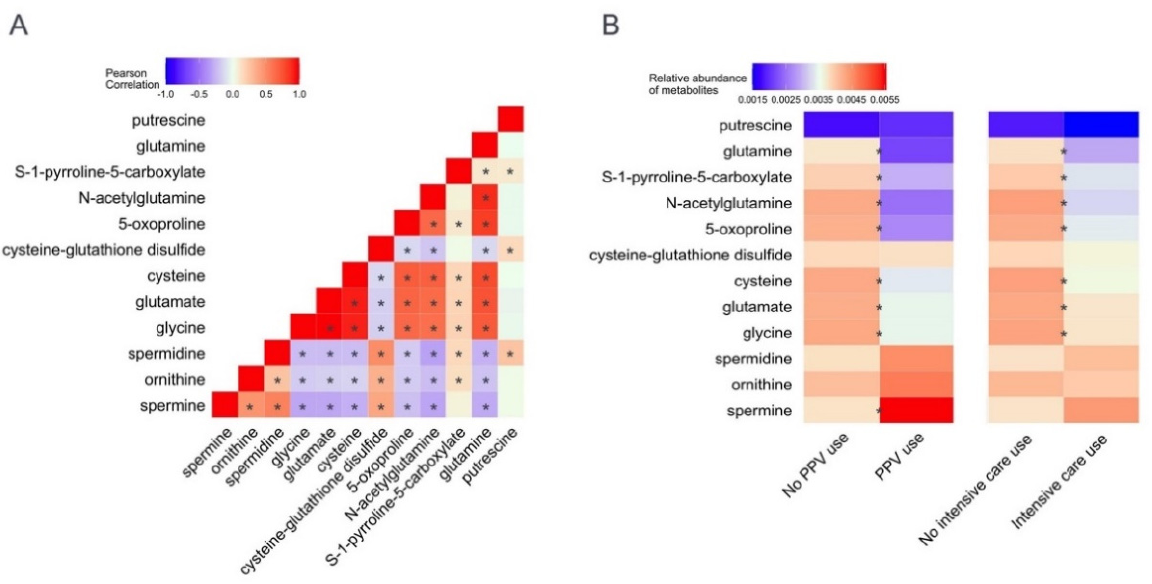
Figure 2. Correlations between nasopharyngeal glutathione-related metabolites and associations of glutathione-related metabolites with severity outcomes in infants hospitalized for bronchiolitis. ( A ). The heatmap shows the correlation between 12 measured nasopharyngeal glutathione-related metabolites. Glutathione substrates (i.e., cysteine, glycine, and glutamate) were positively correlated with each other. In contrast, these metabolites were negatively correlated with oxidized glutathione state (cysteine-glutathione disulfide). * p -value < 0.05 that is estimated by Pearson correlation coefficient. ( B ). The heatmap shows the association of nasopharyngeal glutathione-related metabolites with each of the two clinical outcomes. The relative abundance of glutathione substrates (i.e., cysteine, glycine, and glutamate) was lower in the PPV use group and the intensive care use group compared to their reference groups, suggesting their depletion. In contrast, the relative abundance of metabolites that bind glutathione (e.g., spermine) was higher in the PPV use group. The association of each metabolite with each outcome is shown in Figure 3. * FDR < 0.05 estimated by unadjusted logistic regression models. Abbreviations: FDR, false discovery rate; PPV, positive pressure ventilation.